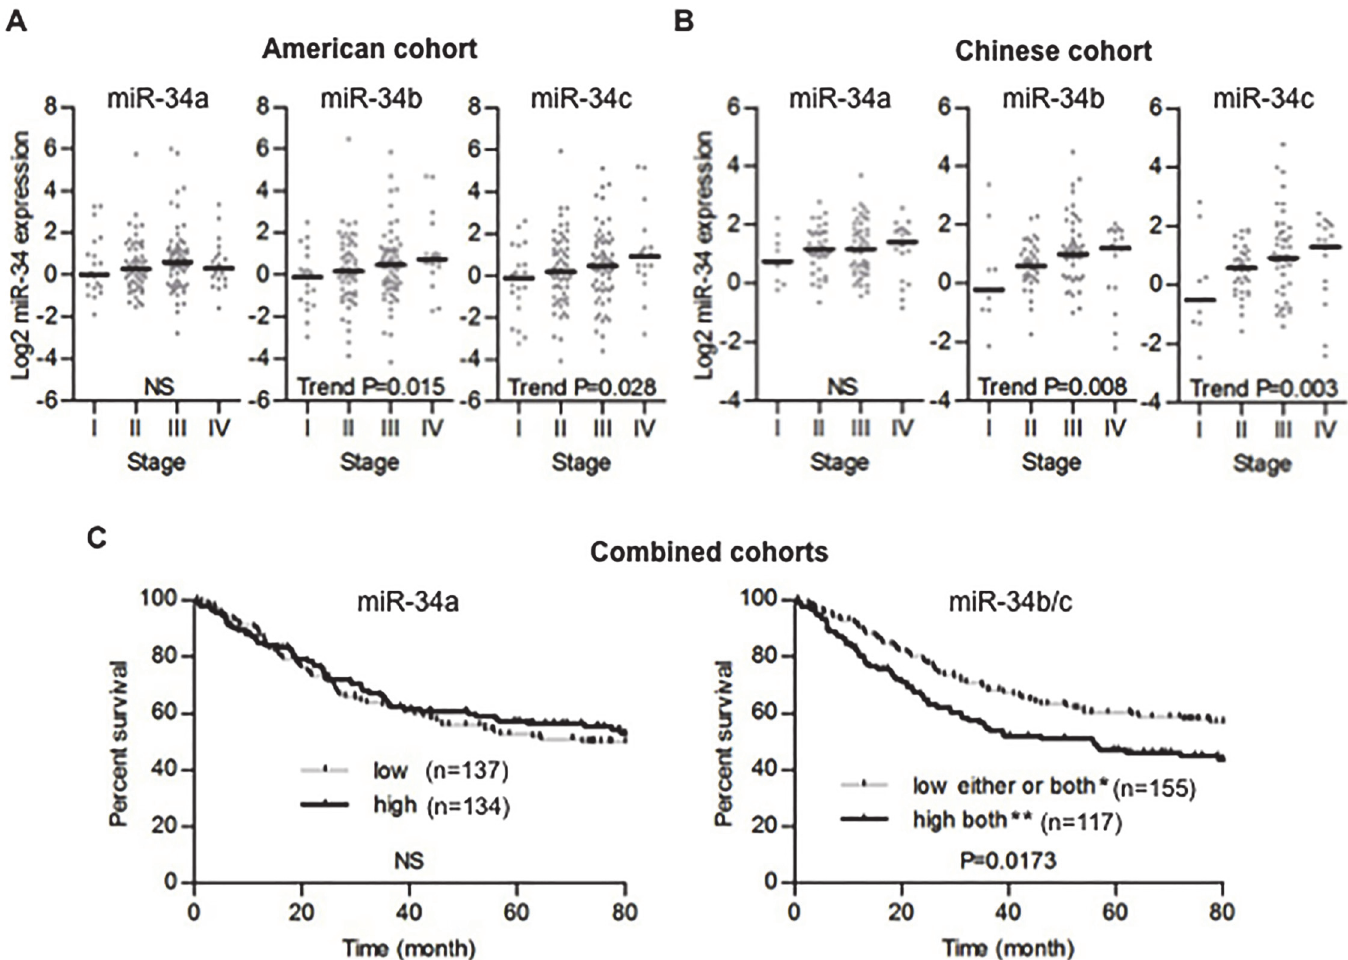
Fig 2. The high expression of miR-34b/c is associated with advanced colon tumor and poor prognosis. (A, B) Tissues were ordered from TNM stage I to IV tumors in the American cohort (A) and the Chinese cohort (B). Dot plots represent miR-34a/b/c threshold cycle values from TaqMan qRT-PCR normalized to U66. Horizontal bars indicate median expression value. The Cuzick nonparametric test for trend was used to evaluate trends. (C) Kaplan-Meier survival analysis of all stage cases in the American and Chinese combined cohorts stratified by median miR-34a expression and combined miR-34b/c expression. * Cases with low miR-34b and/or low miR-34c. ** Cases with both high miR-34b and high